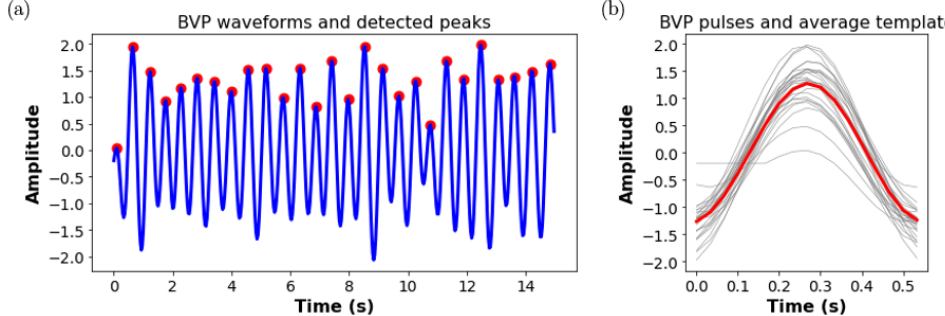
Figure 12. Demonstration of signal quality assessment, ( a ) A 15s rBVP waveform and detected peaks using proposed approaches, ( b ) rBVP pulses (gray curves) and the averaged rBVP template (red curves), SQI =